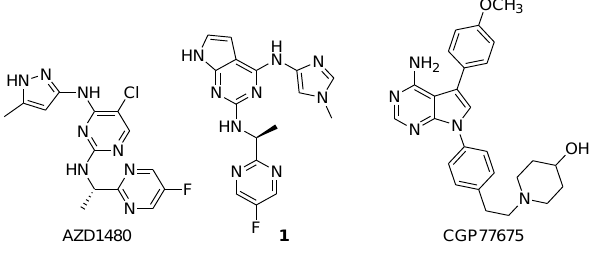
Figure 2. Molecular structures of AZD1480, 1 , and CGP77675.